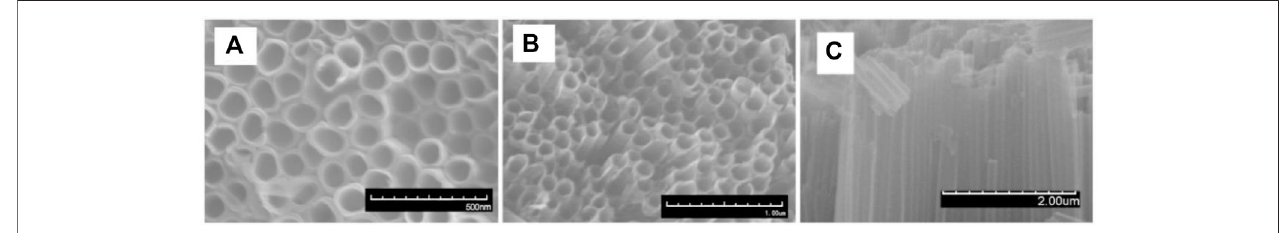
FIGURE 1 | SEM images of titania nanotubes prepared by anodization of Ti substrate: (A,B) , top view (C) cross-sectional view. Reprinted with permission from (Tong et al.,